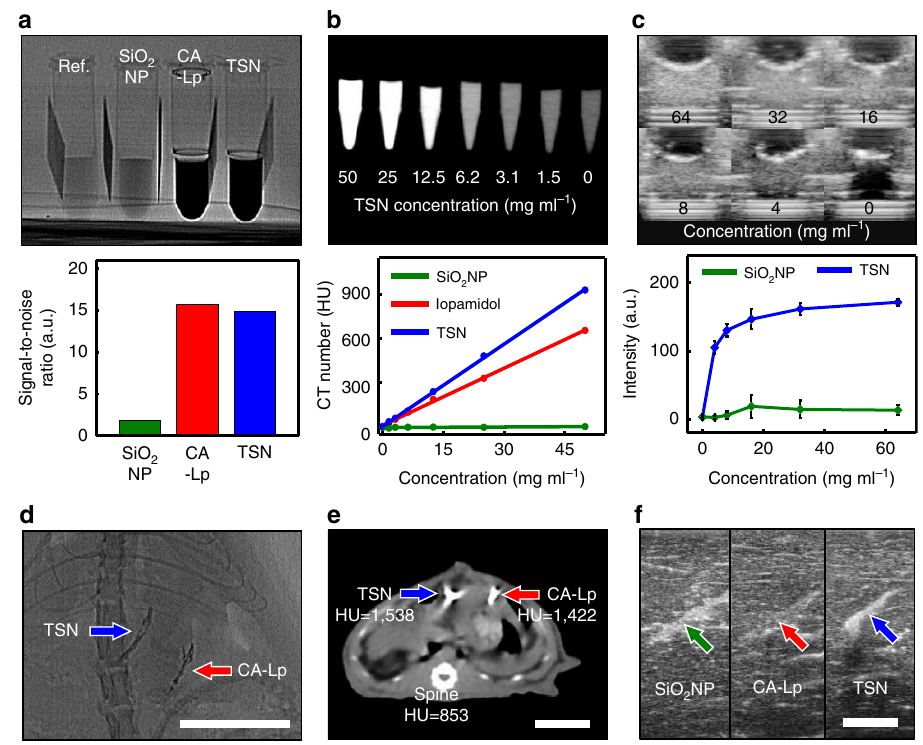
Figure 3 | Contrast enhancement of TSNs on various imaging modalities in vitro and in vivo . ( a ) Contrast enhancement on X-ray fluoroscopy. Fluoroscope image of the tubes containing water (Ref.), commercial silica nanoparticle solution (SiO 2 NPs, 50 wt%), mixture of cyanoacrylate adhesive and iodized oil (CA-Lp, 75% of Lipiodol, 360mgml (cid:2) 1 of iodine), and TSNs (40 wt%), and bar plot of the calculated signal to noise ratio from the image). ( b ) Contrast enhancement on computed tomography (CT). CT image of microtubes containing serially diluted TSNs, and line graph of CT contrast enhancement of SiO 2 NPs, contrast agent (iopamidol), and TSNs against their concentrations. ( c ) Contrast enhancement on ultrasonography. Ultrasonography images of TSN phantoms, and a plot of the mean intensities with s.d. of TSNs and SiO 2 NPs against their concentrations. ( d , e ) In vivo images of a Sprague Dawley (SD) rat after application of TSNs and CA-Lp on fluoroscopy ( d ) and CT ( e ). On the CT image ( e ), the mean CT values (Hounsfield unit, HU) of each region of interest (TSN, CA-Lp, and bone) were measured. ( f ) Ultrasonography images of the calf liver where SiO 2 NPs, CA- Lp and TSNs were injected. Scale bars in d – f indicate